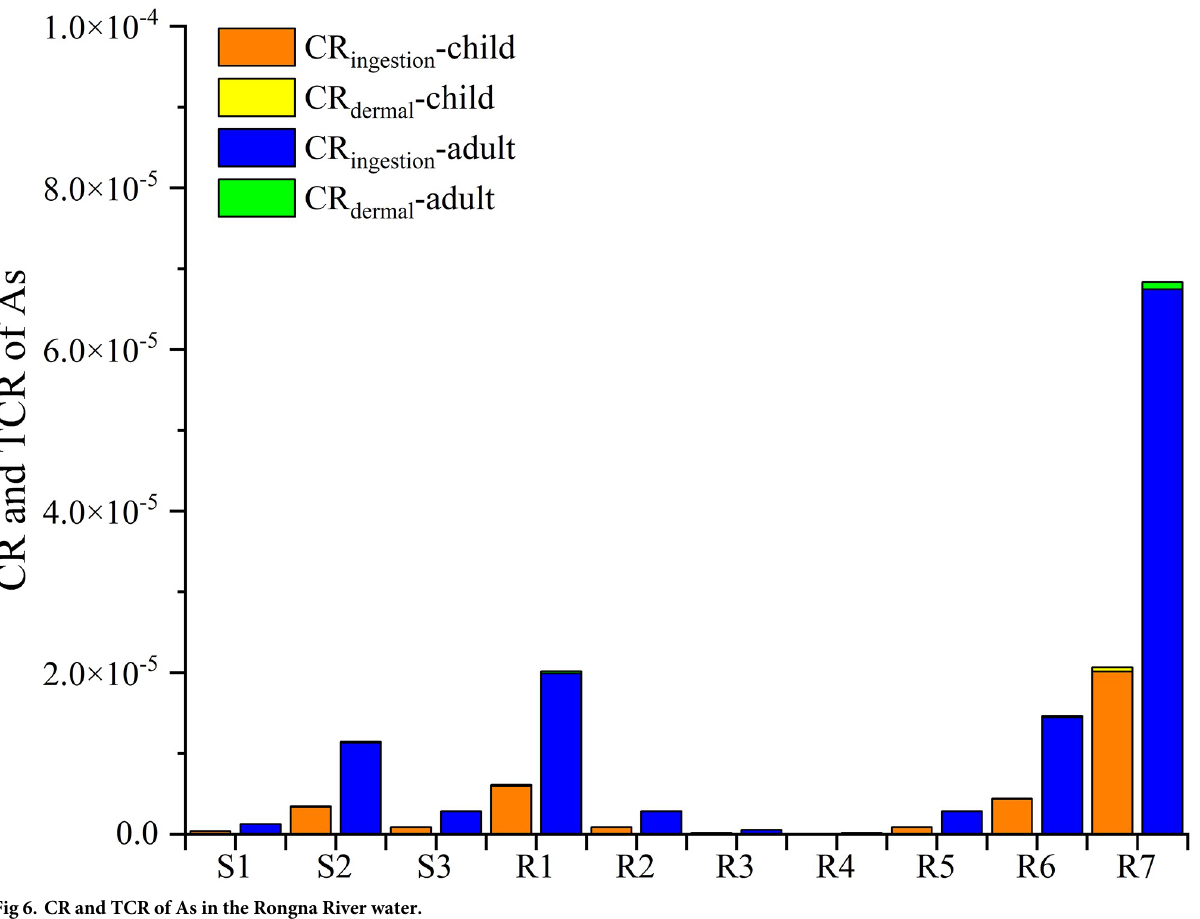
Fig 6. CR and TCR of As in the Rongna River